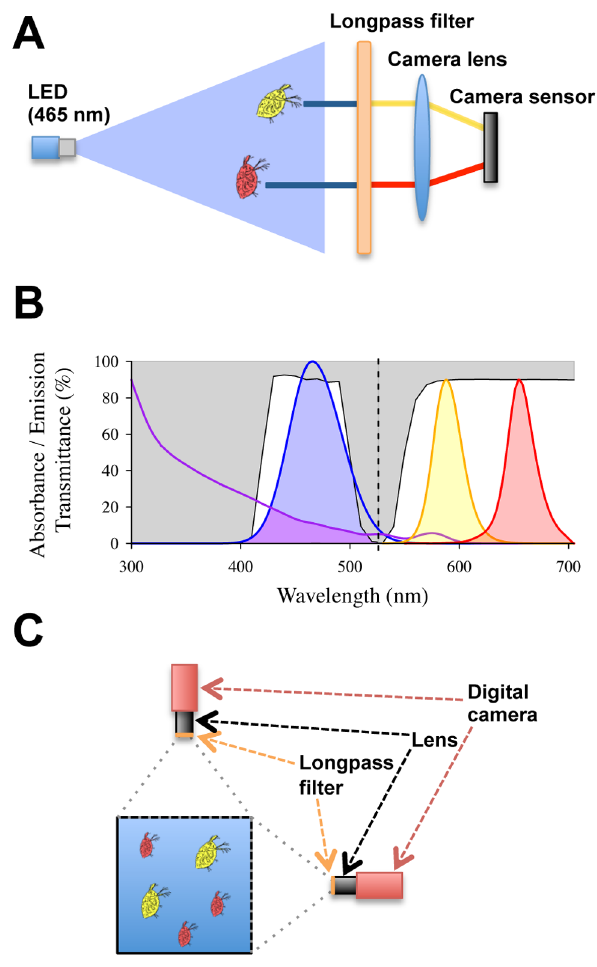
Figure 1. Schematic illustration of fluorescence system. (a) Schematics of the tracking setup. Light emitted from the excitation source (a light-emitting diode array – LED array) causes the quantum dots to fluoresce. The emitted fluorescence is filtered and focused on a camera sensor. (b) Quantum dots are excited in the emission range of a blue LED array (blue line) filtered by a bandpass filter to out light of unwanted wavelengths (white area, left side of the panel). The blue area represents the light available for the excitation; the light absorbed by the quantum dots is represented by the purple area below the quantum dot absorbance spectrum (purple line). The emission spectrum of the quantum dot fluorescent at 585 nm and 655 nm (yellow and red lines, respectively) are filtered with a longpass filter (white area, right side of the panel) before being recorded by the camera sensor. All the curves are normalized versus the excitation light (peak at 465 nm). (c) Illustration of camera and aquarium set-up seen from above, showing the placement of, cameras, lenses, camera filters and aquarium.